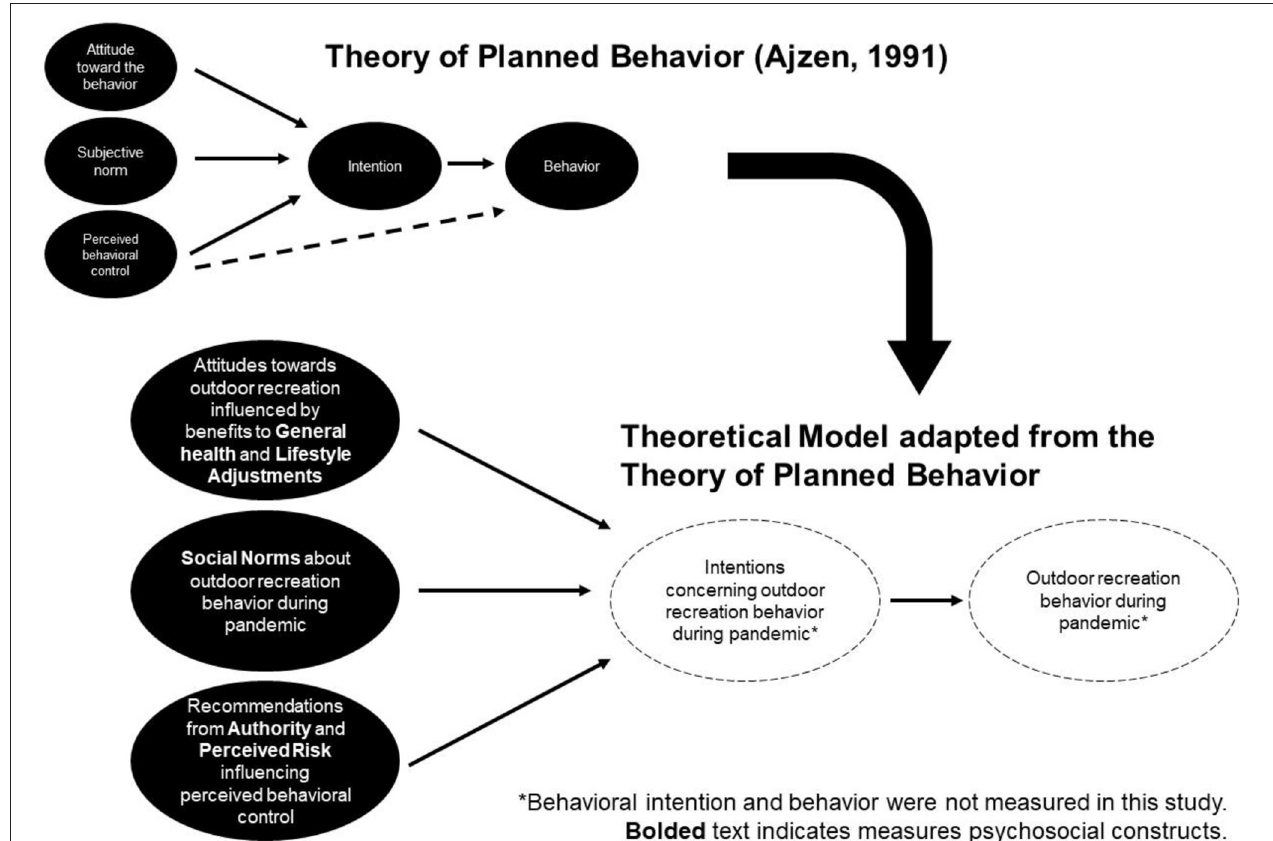
FIGURE 1 | Extension of the Theory of Planned Behavior (Ajzen, 1991) to incorporate psychosocial constructs of interest influencing outdoor recreation behaviors during the COVID-19